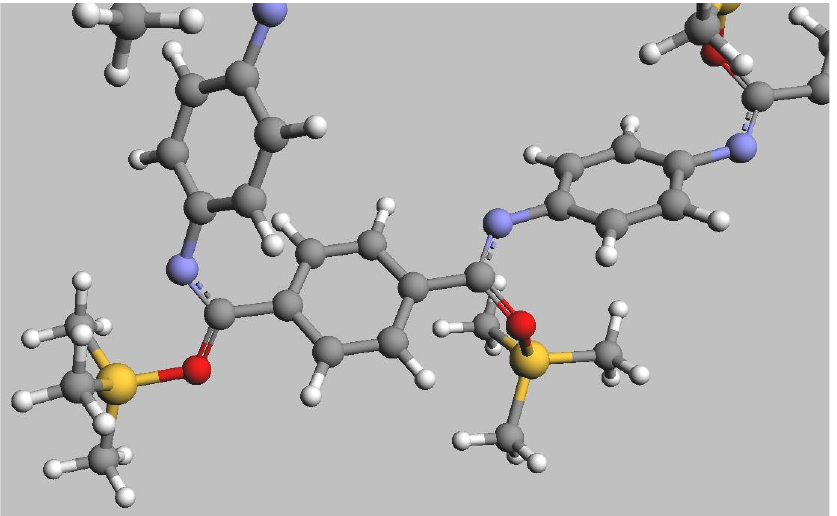
Figure 2. Molecular representation of a PPTA chain in which the amide groups are silylated, with one of them having a cis conformation (left part of the graph) and the other a trans conformation (right part of the graph).